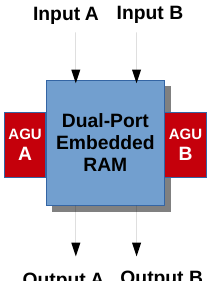
Figure 5. Dual-port embedded memory with Address Generation Units